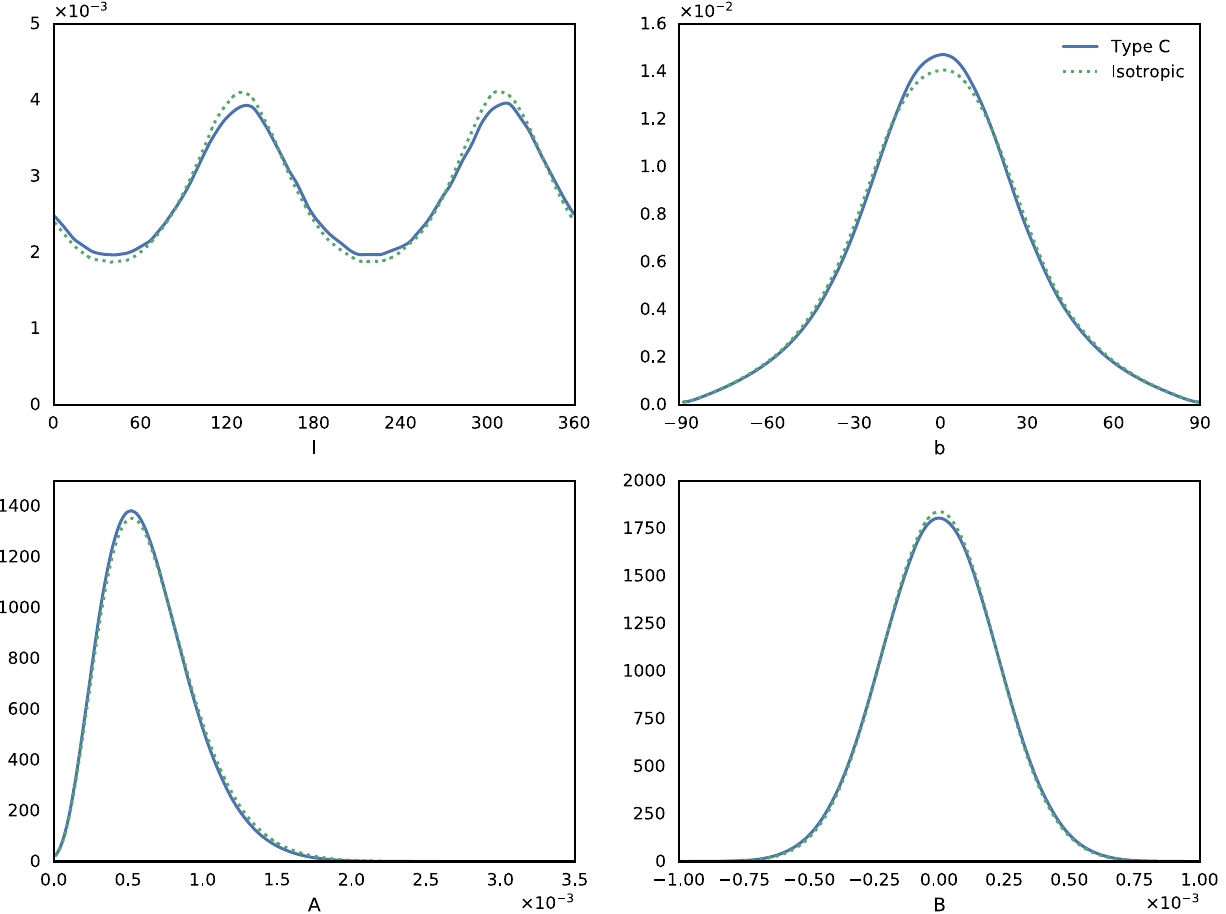
Fig. 20 Likelihood of parameters for type C samples and isotropic samples. No significant deviation caused by the different spatial distribution of redshifts is